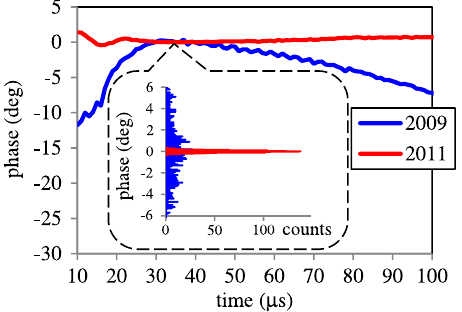
FIG. 3. The rf gun phase stability and jitter before and after the upgrade. The main diagram shows the phase distribution within an rf pulse. The inserted histograms are illustrating shot-to-shot phase jitter measurements performed for the first bunch location within the rf pulse.